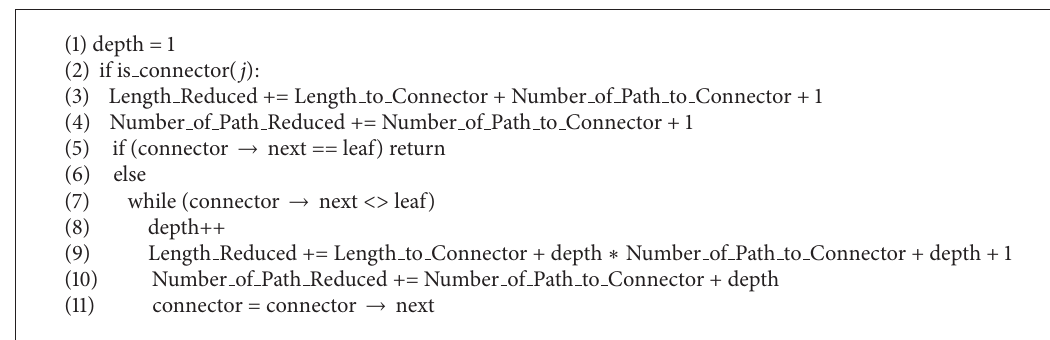
Algorithm 2: Restore the ASPL of 𝐺 from the multisimplified